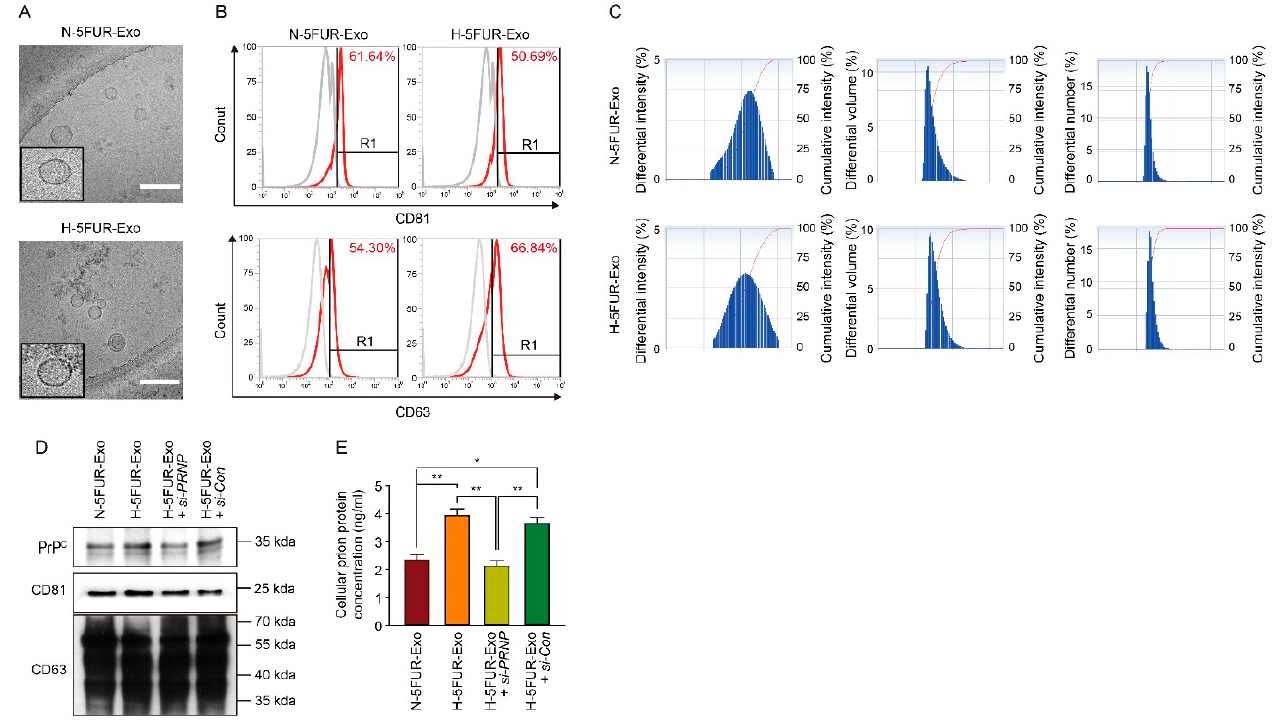
Figure 3. Characterization of exosomes secreted by normoxic and hypoxic drug-resistant CRC cells. ( A ) Representative cryo-electron microscopy analysis of exosomes isolated from SNU-C5/5FUR under normoxic and hypoxic conditions (n = 3). Scale bar = 200 nm. ( B ) Representative flow cytometry histogram of exosome markers, CD81 and CD63, on exosomes under normoxic and hypoxic conditions for 48 h (n = 3). ( C ) Size distribution analysis by dynamic light scattering (n = 3). ( D ) Expression of PrP C , CD81, and CD63 in N-5FUR-Exo, H-5FUR-Exo, H-5FUR-Exo + si-PRNP , and H-5FUR-Exo + si-Con (n = 3). ( E ) ELISA analysis of PrP C expression in N-5FUR-Exo, H-5FUR-Exo, H-5FUR-Exo + si-PRNP , and H-5FUR-Exo + si-Con (n = 3). Data are represented as the mean ± SEM. * p < 0.05, ** p < 0.01 (ANOVA).